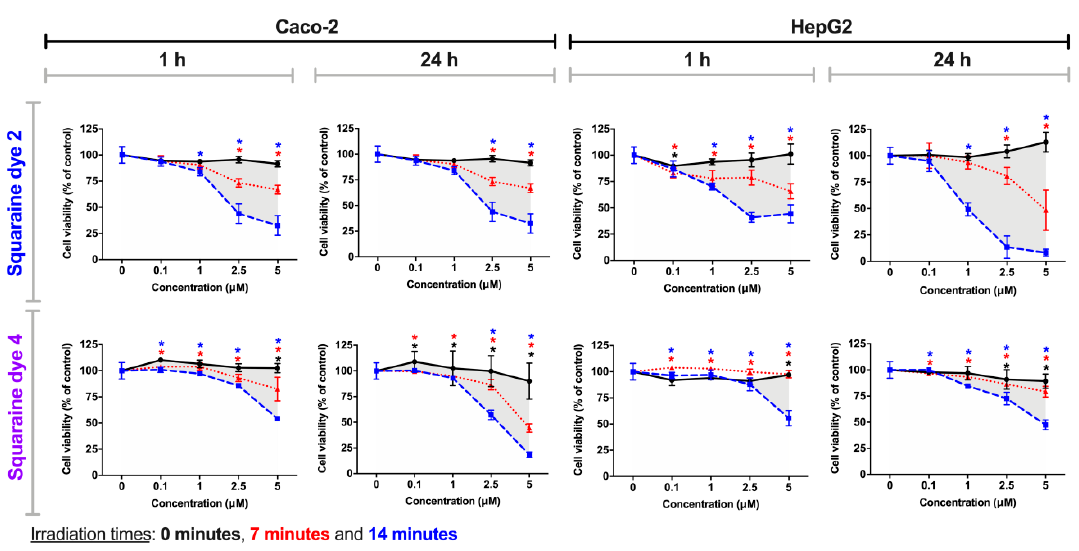
Figure 7. Photodynamic effects of dicyanomethylene squaraine dyes 2 and 4 on Caco-2 and HepG2 cells. After cells incubation for 24 h with the respective dye (at 0.1, 1, 2.5 and 5 µM), cells were irradiated with suitable light-emitting diode systems for 0, 7, and 14 min (black, red and blue lines, respectively). After irradiation, the cells were maintained in contact with the irradiated dyes for 1 h or 24 h, and Alamar Blue reduction assay was performed for cell viability assessment. Results are expressed as % of control, non-treated cells, and presented as mean ± standard error of the mean (n = 3 independent experiments; each experiment in quadruplicates). Conditions with statistical significance compared to the negative control ( p -value < 0.05) are indicated by an asterisk (*) of the color relative to the irradiation time. The shaded area delimits the difference in the percentage of cell viability between treatment with and without irradiation.